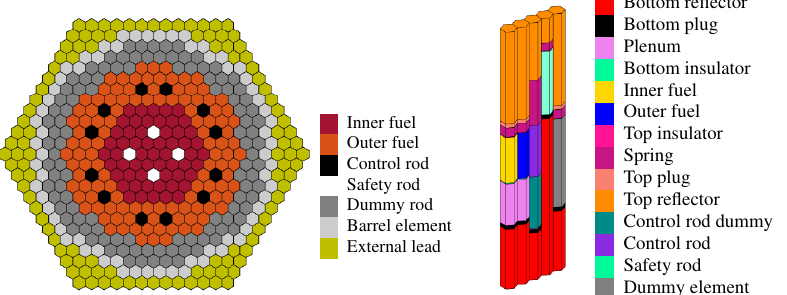
Figure 2: Radial (left) and axial (right) sections of ALFRED 3D